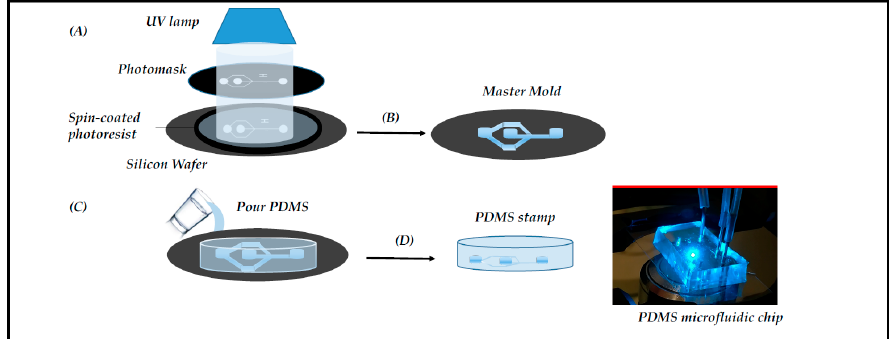
Figure 1. Microfabrication of the chips by photolithography. The main steps of photolithography are: ( A ) Negative SU8 photoresist exposure to UV radiation in order to obtain the pattern drawn on the photomask; ( B ) Photoresistive development to obtain the master mold; ( C ) Pouring the PDMS on the master mold; ( D ) Curing and peeling off the PDMS stamp; finally, making holes in the PDMS for external tubing and binding to a glass slide for microscopy (right picture).